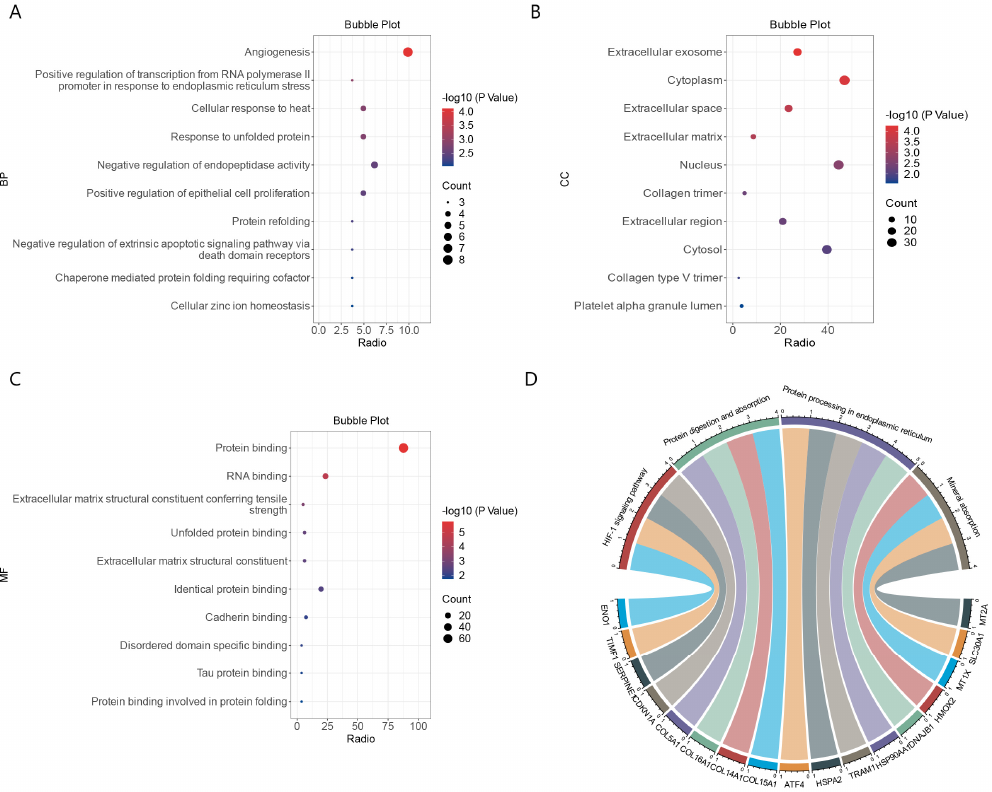
Figure 3. Functional enrichment analysis of DEGs common to COVID-19 and ICM. ( A ) Enriched gene ontology (GO) terms under biological process. ( B ) Enrichment GO terms under cellular component. ( C ) Enriched GO terms under molecular function. ( D ) String diagram of enriched KEGG pathways.